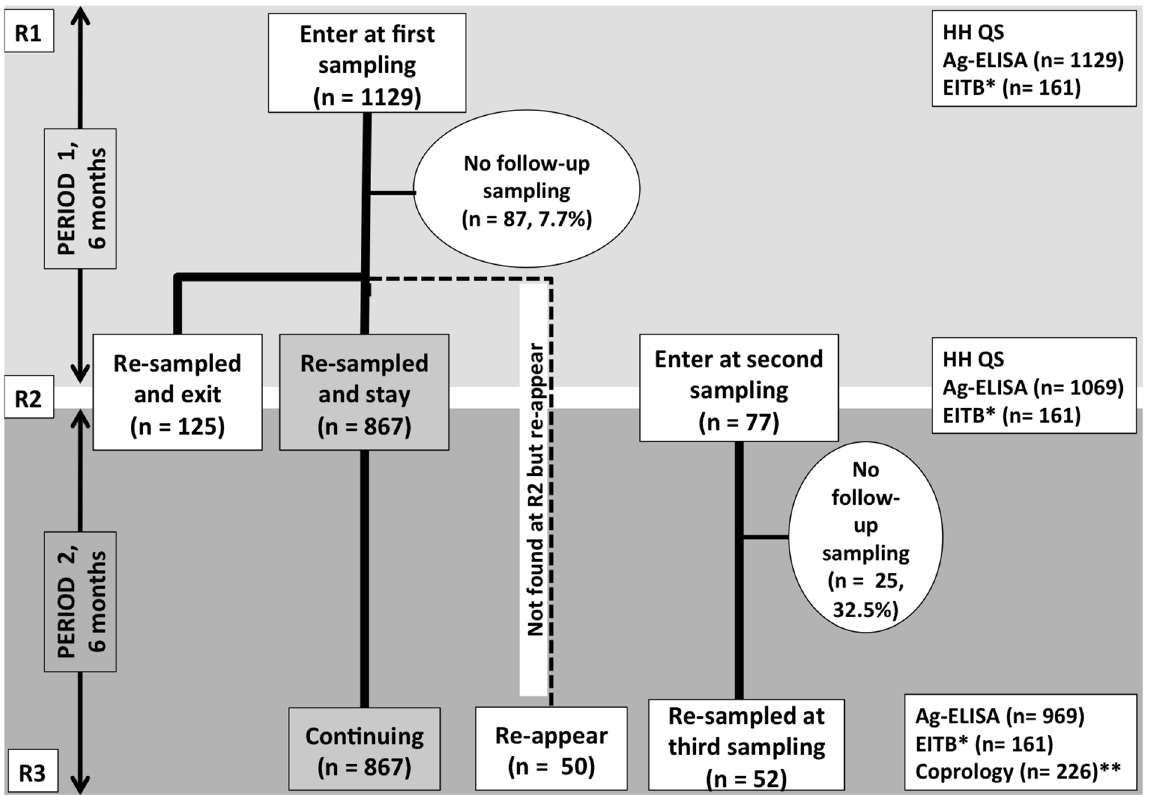
Figure 2. Cohort composition and changes during the three sampling rounds. (Format adapted from Garcia et al ., 2003 [18]). R1, R2 and R3 stand for first, second and third round of sampling. Ag-ELISA: detection of circulating cysticercus antigen in serum; EITB: detection of specific antibodies in serum; HH QS=household questionnaire; Coprology: coproscopy and Copro-Ag-ELISA. *Only carried out on a randomly selected sample of 161. **Carried out on stool samples collected at R3.